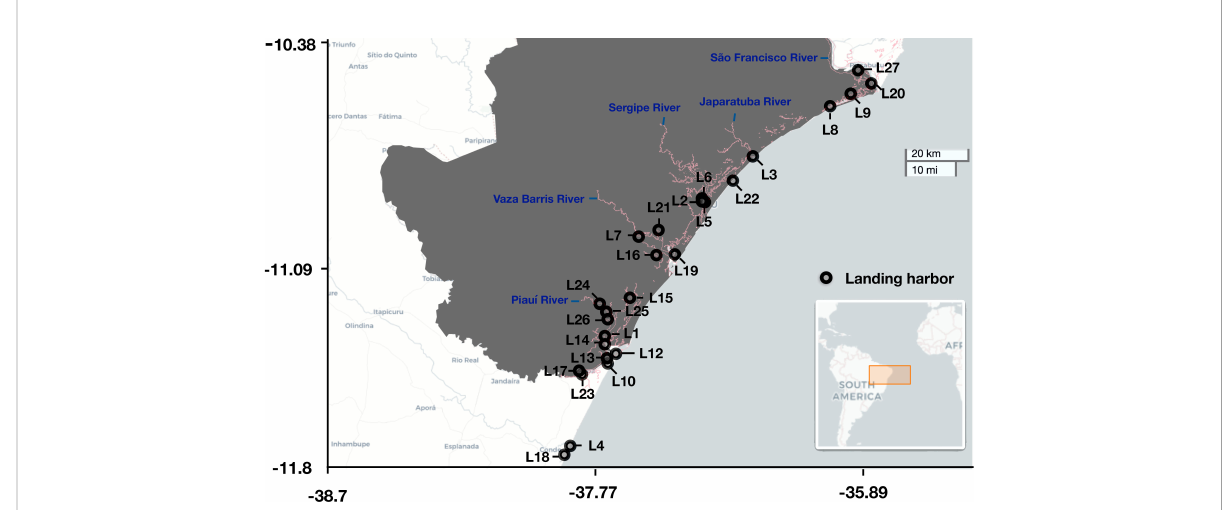
FIGURE 1 Study area on Sergipe State (Brazil) with locations of the 27 landing harbors for small-scale fi